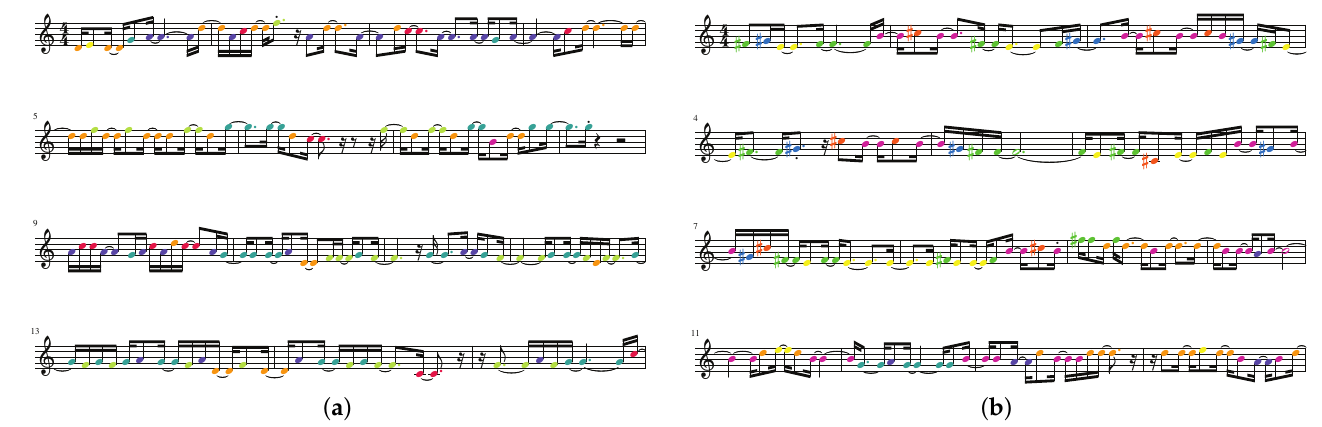
Figure 13. Traditional Chinese Pentatonic scale music generation fragments of 3D-SCN ( a ) and BoYaTCN ( b